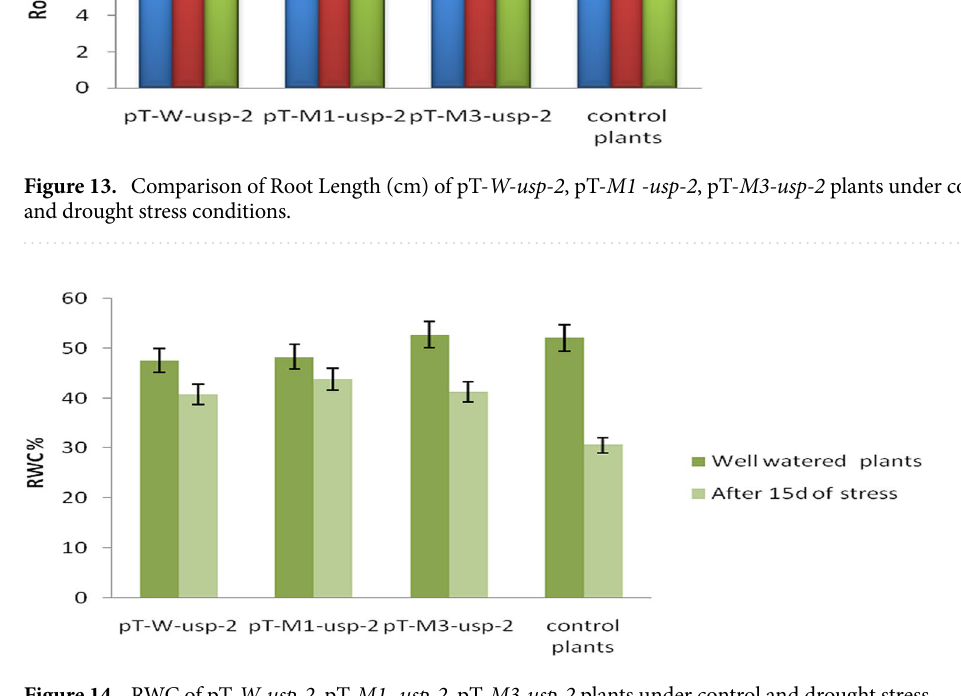
Figure 14. RWC of pT- W-usp-2 , pT- M1 -usp-2 , pT- M3-usp-2 plants under control and drought stress